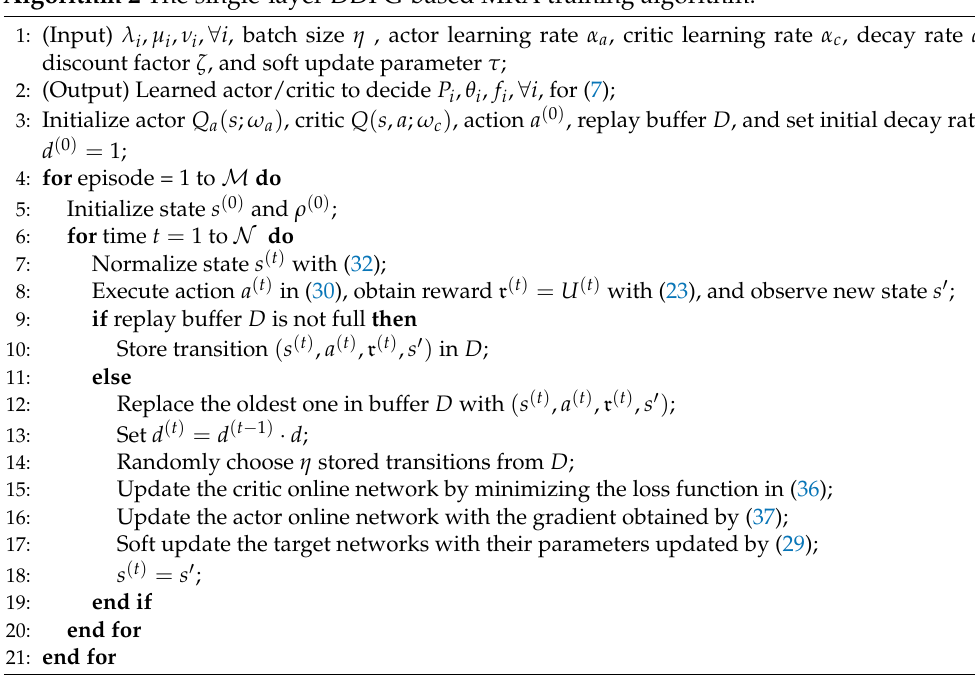
Algorithm 2 The single-layer DDPG-based MRA training